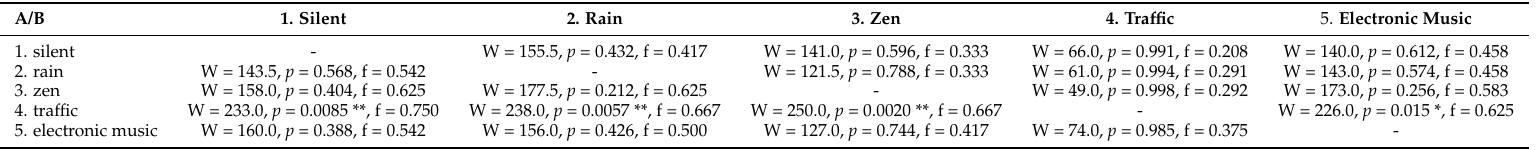
Table 3. Results of the Wilcoxon signed rank-sum test for mean interaction time per 30 min with H 0 that the median of differences is 0, the alternative hypothesis H 1 being that it is positive, i.e., A is preferred over B. Effect size f is given as fraction of pairs that support the alternative hypothesis. * p < 0.5, ** p <